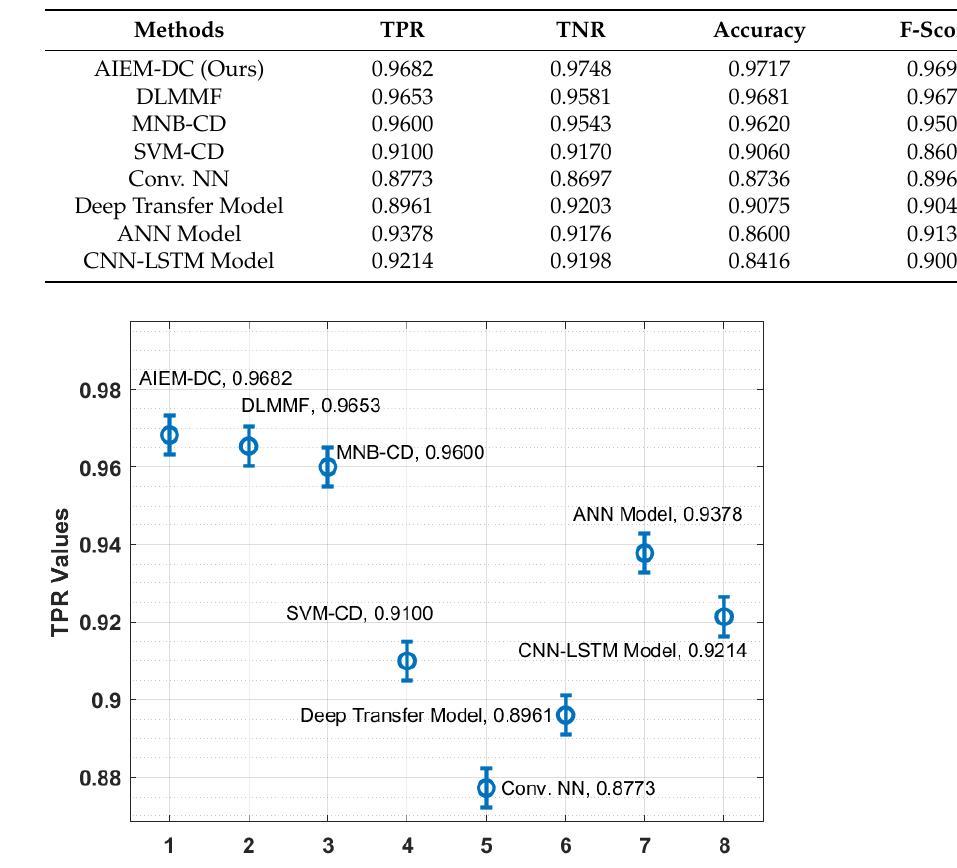
Table 2. Comparative analysis of existing with proposed AIEM-DC method with recent methods [35].